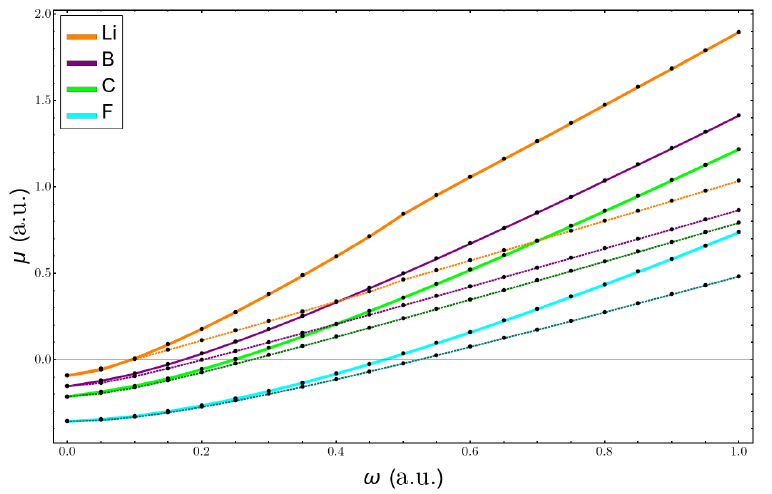
Figure 9. Variation in the electronic chemical potential with confinement. Solid lines correspond to the calculations solving the Hartree–Fock equations, and broken lines are the perturbation theory